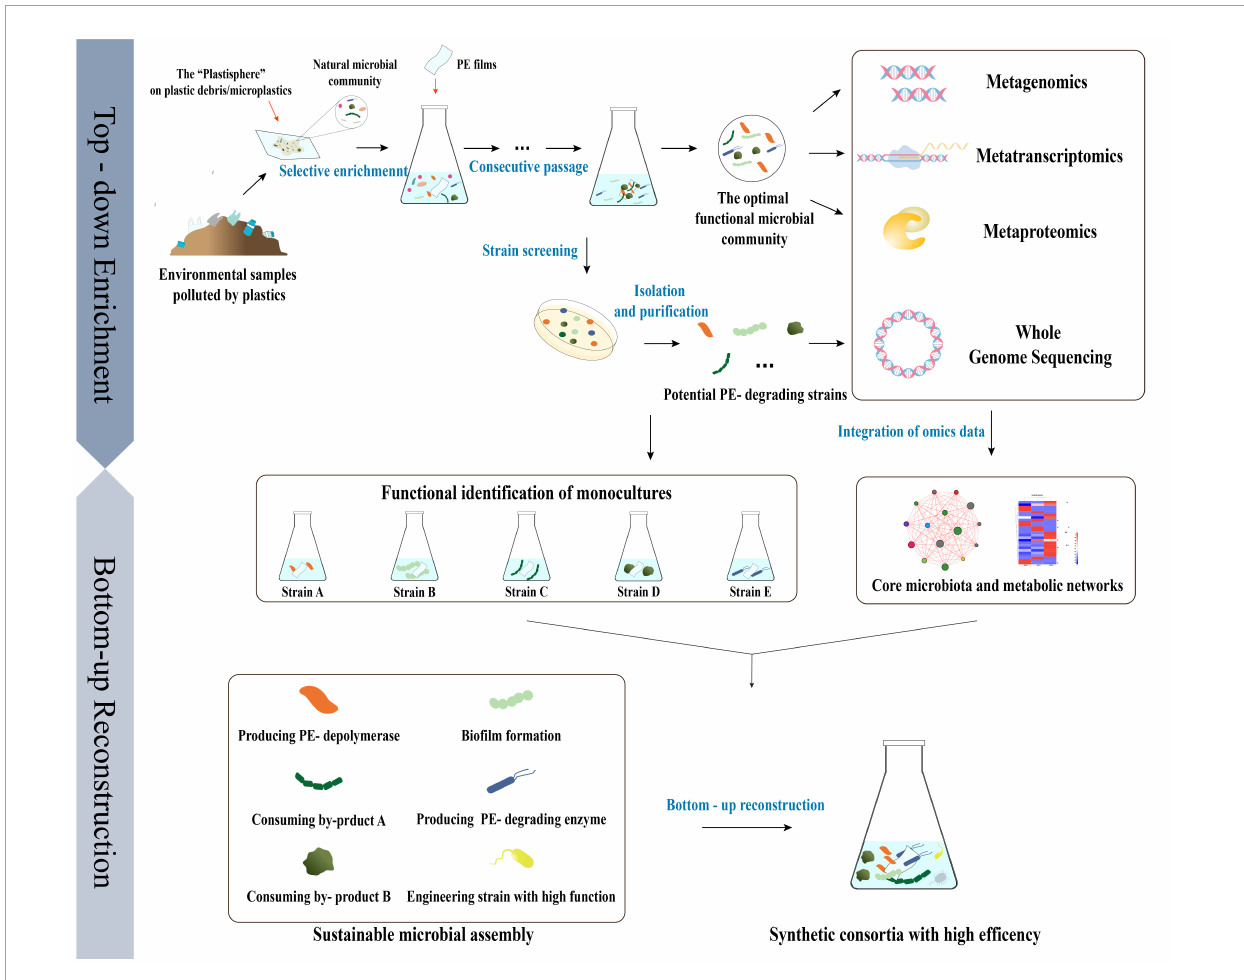
FIGURE4 The strategy of “top-down” enrichment and “bottom-up” reconstruction combined to develop efficient PE degrading microbial consortia based on multi-omics analysis of the natural microbial community derived from the “Plastisphere” and the functional microbial community achieved after